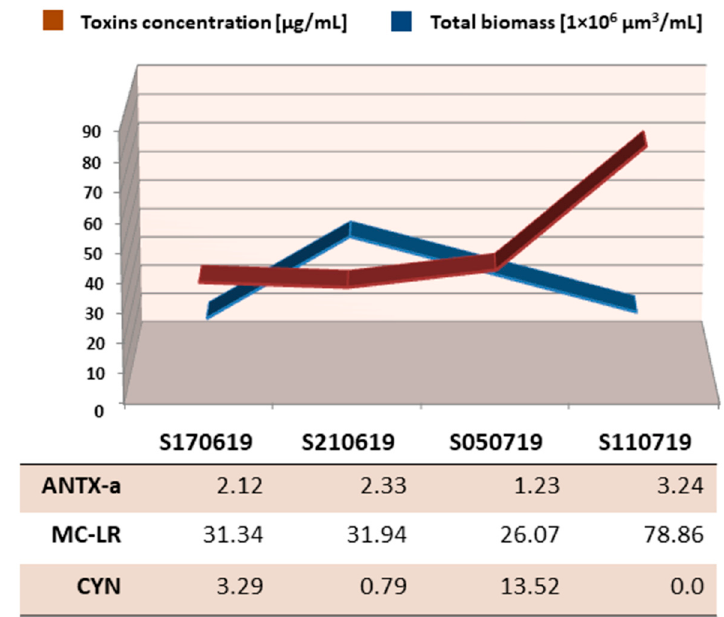
Figure 10. Concentration of cyanotoxins in samples from Stryków artificial reservoir against total cyanobacterial biomass.